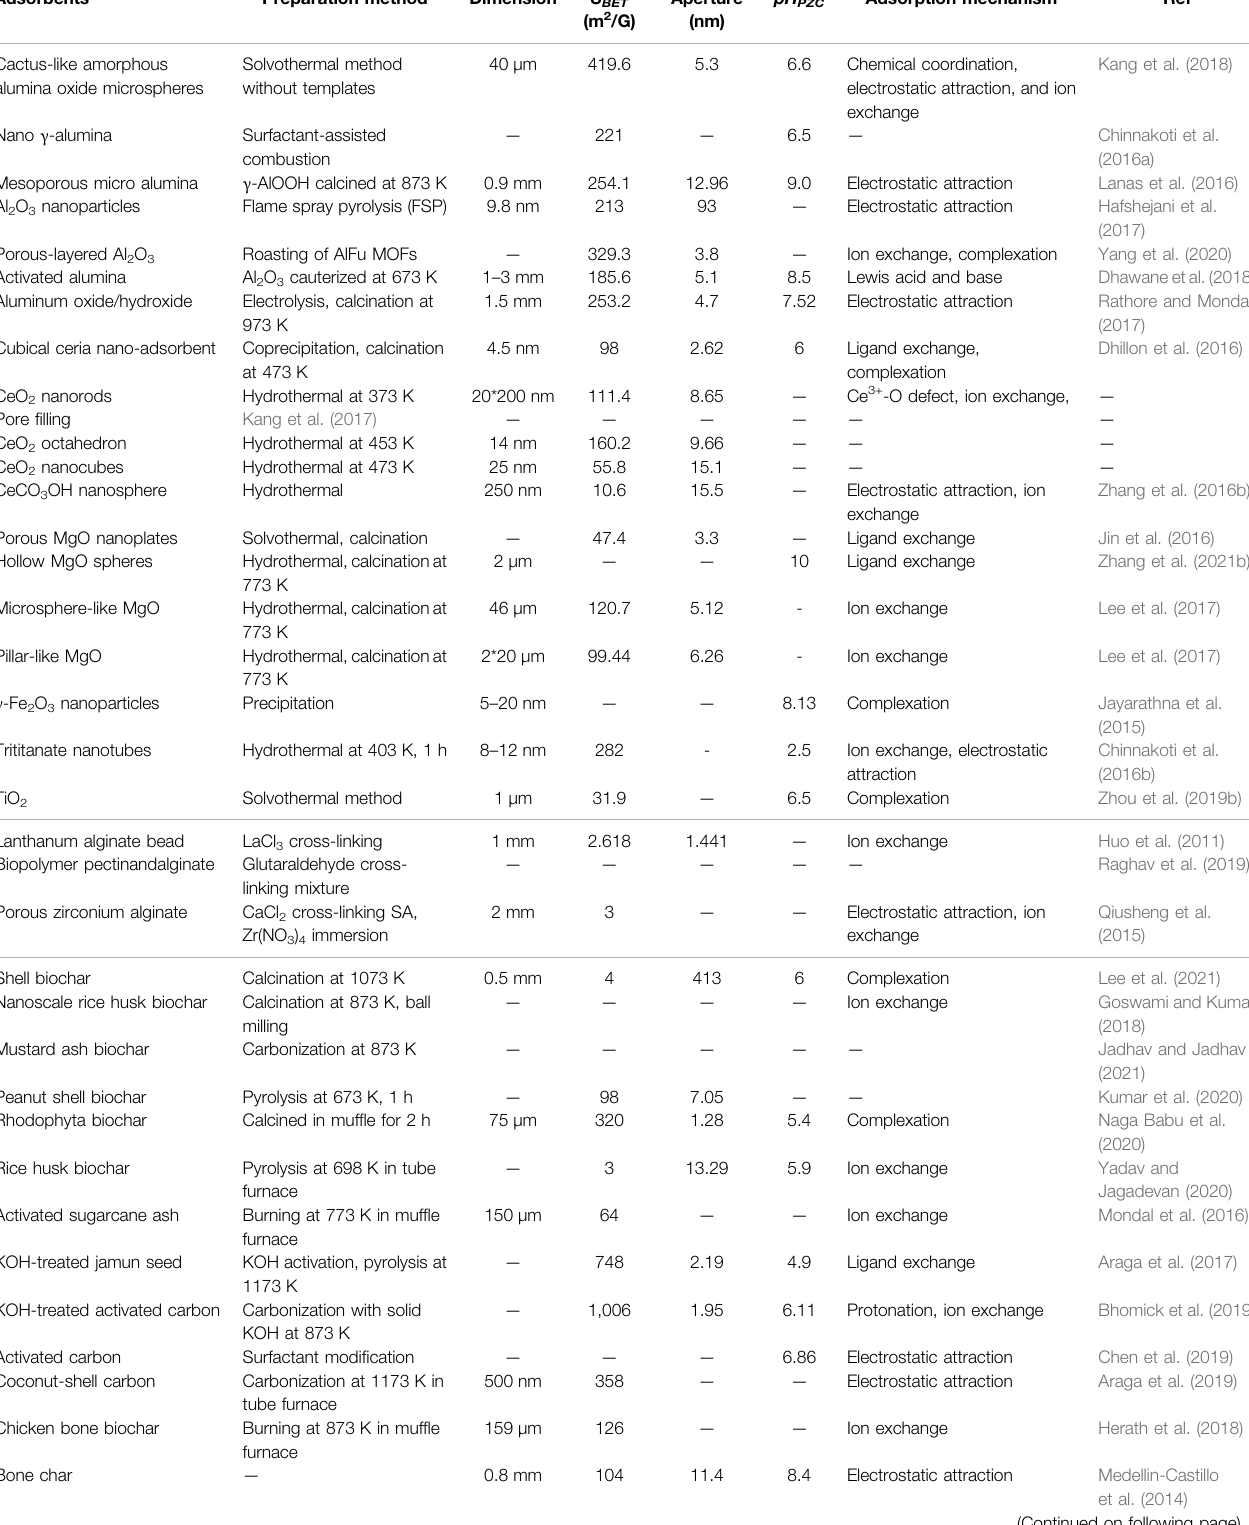
TABLE 1 | Summary of the preparation methods, characteristics, and adsorption mechanisms of four traditional